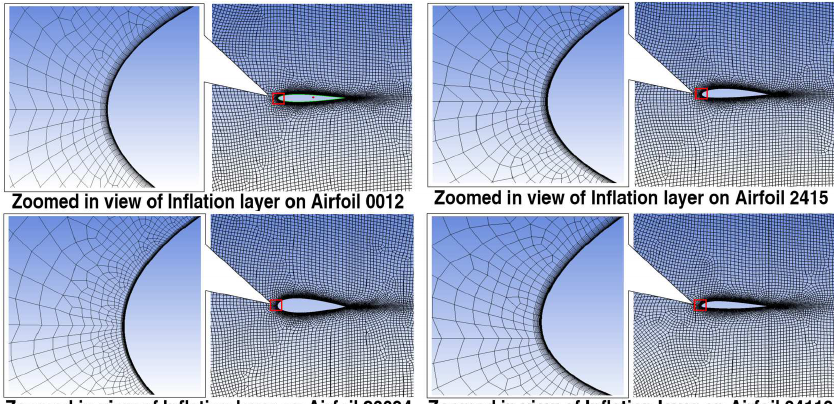
Figure 1. Airfoils with unstructured meshes.